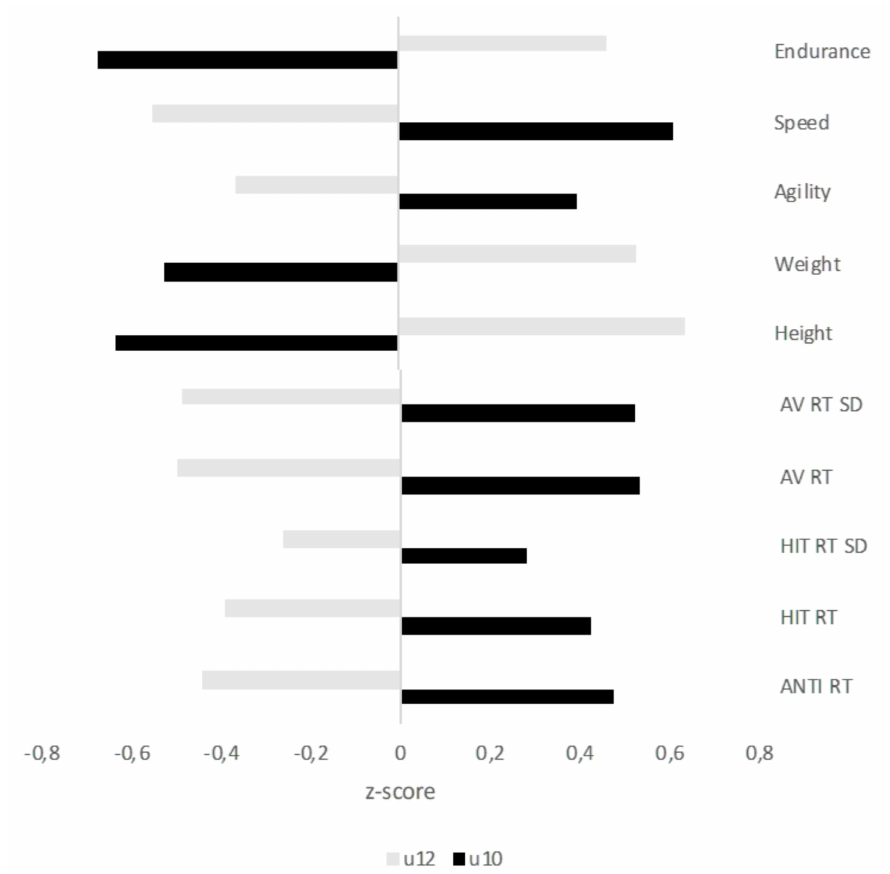
Figure 4. Mean standardized Z-scores for anthropometrics, physical fitness and cognitive measures showing a statistically significant main e ff ect of Age